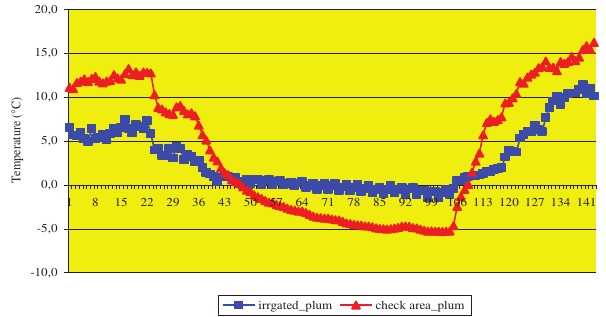
Figure 7 – Temperatures as changing in the anti-frost spraying experiment with 10 minute intervals (blue) related to the check area (red) at Pallag between April 9. 09.00 and 10. 09.00, 2012.